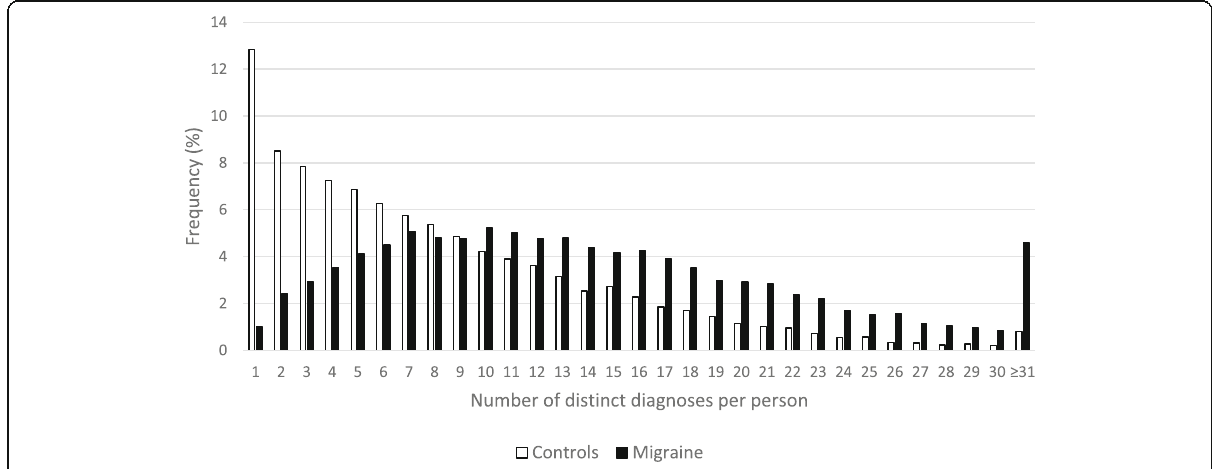
Fig. 1 The frequency of patients per distinct number of diagnoses per patient among patients with migraine and